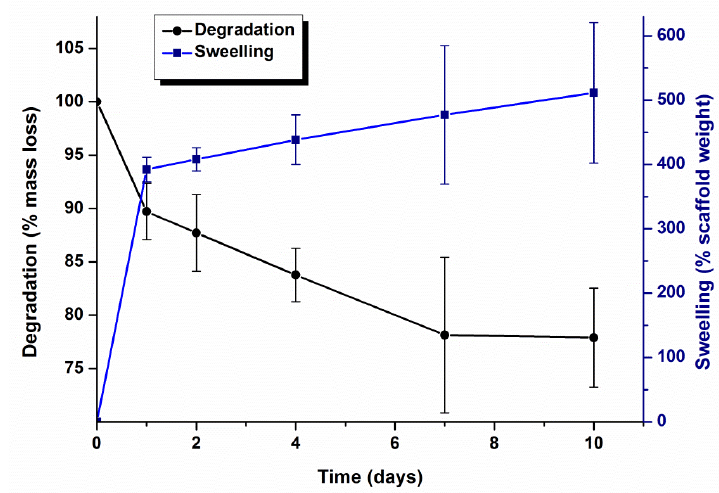
Figure 4. Swelling and degradation profiles of biomimetic scaffolds after 10 days of immersion in PBS of pH 7.4 at 37 °C. Lines are a guide to the eye.